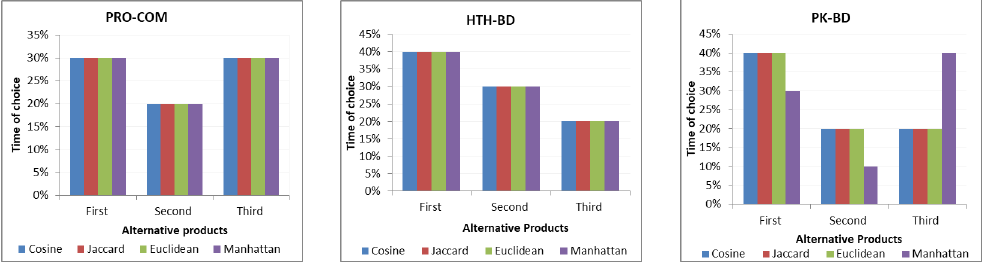
Figure 6. The number of times the alternative products was chosen.